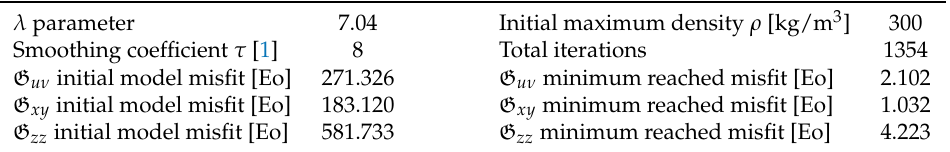
Table 4. Configuration of the gradiometric inversion parameters for the T